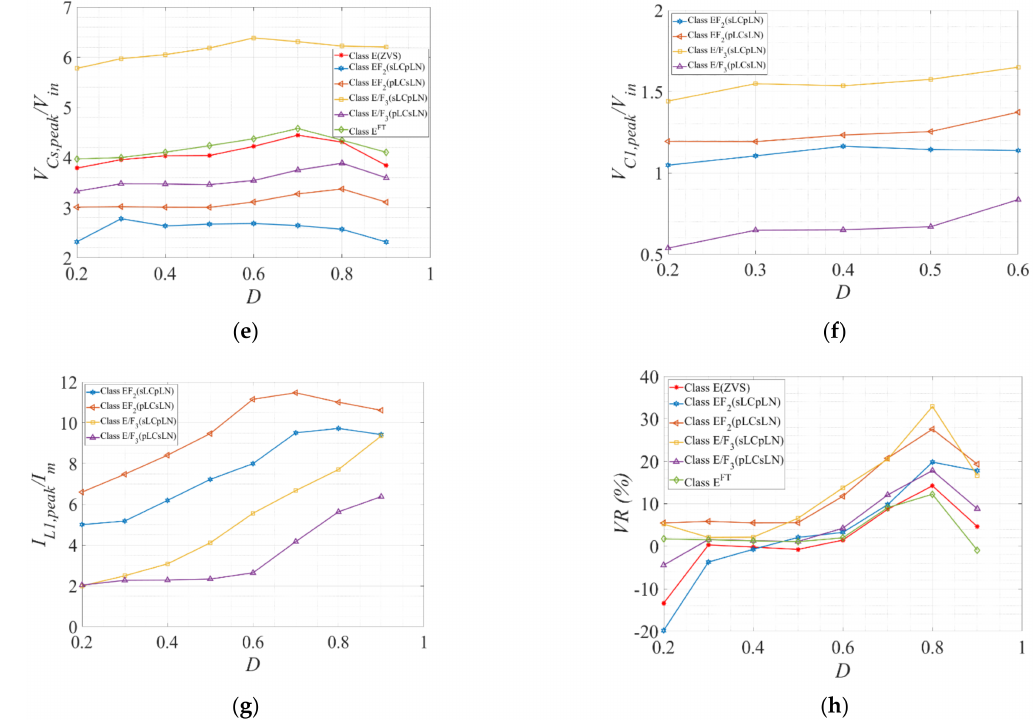
Figure 8. ( a ) The power output capability ( c p ); ( b ) efficiency ( η ); ( c ) the normalized peak switch voltage ( V S1,peak / V in ); ( d ) the normalized peak switch current ( I S1,peak / I m ); ( e ) the normalized peak resonant capacitor voltage ( V cs,peak / V in ); ( f ) the normalized peak auxiliary resonant capacitor voltage ( V C 1 ,peak / V in ); ( g ) the normalized peak auxiliary resonant current